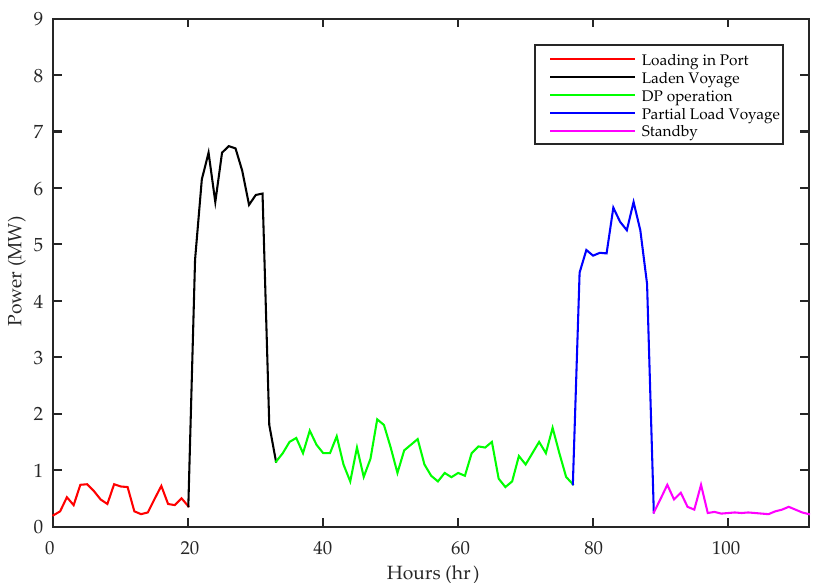
Figure 4. Power demand during the different parts of the